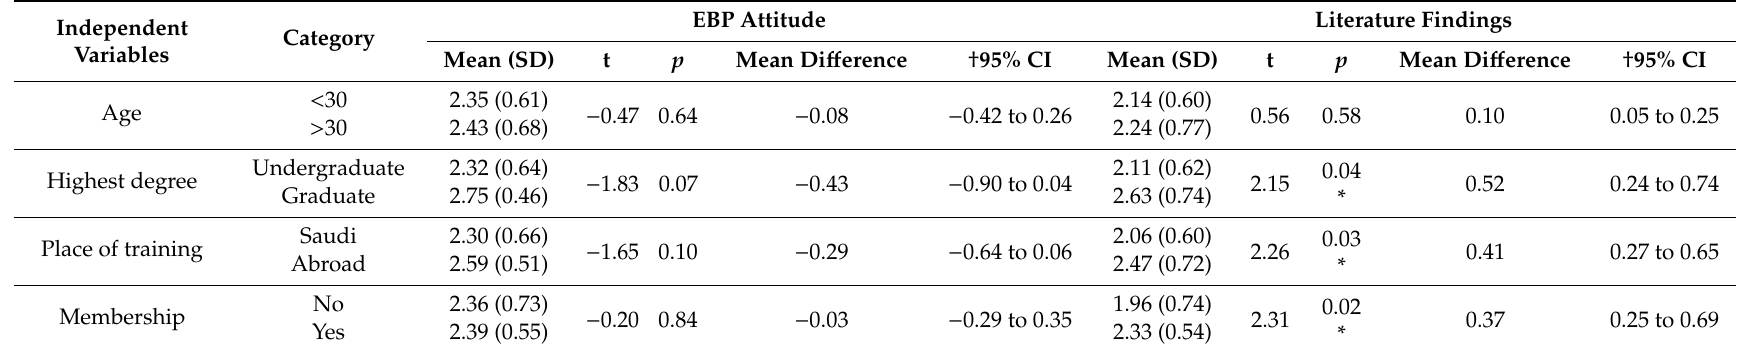
Table 3. Comparison of demographic characteristics and attitudes toward evidence-based practice (EBP) and literature findings.